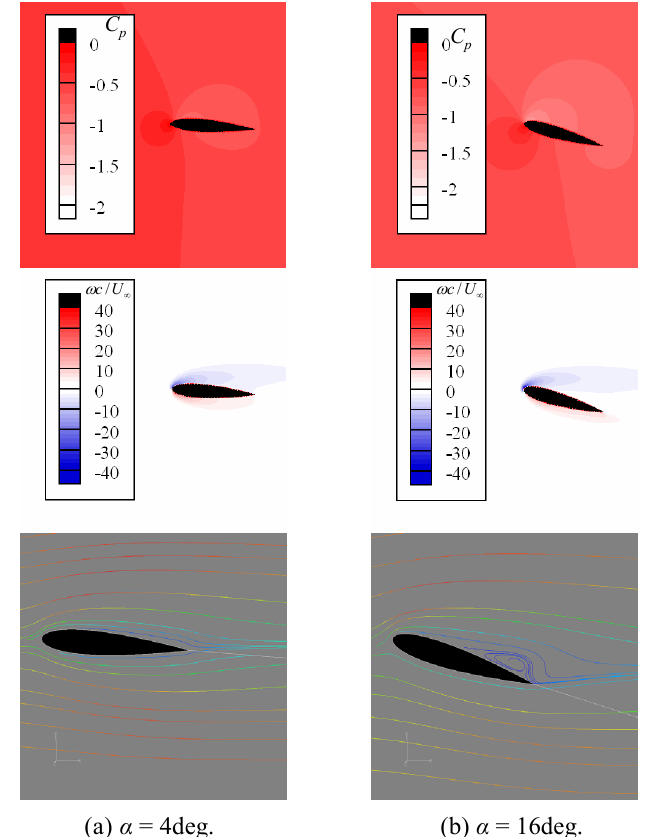
Fig. 8 Pressure distribution, vorticity distribution and streamlines at Re = 1.0×10 2 (NACA0015, α = 4 and 16 deg.).